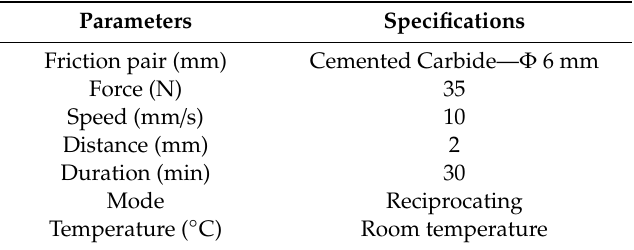
Table 2. Parameters setup in the scratch test.